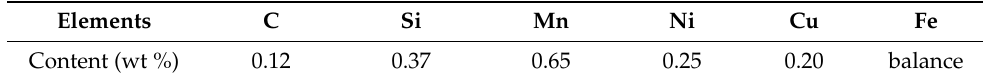
Table 2. Chemical composition of 10#